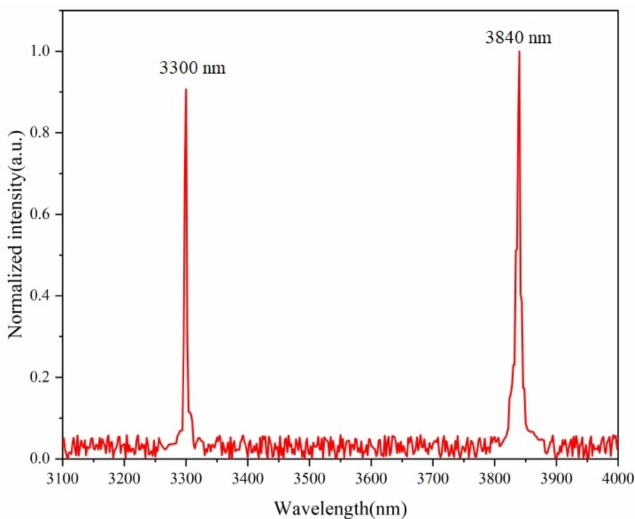
Figure 3. The dual wavelength mid-infrared laser